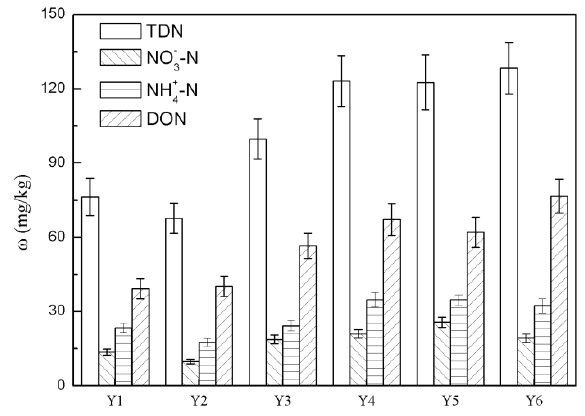
Figure 3. The distribution and forms of nitrogen in each sediment sample.